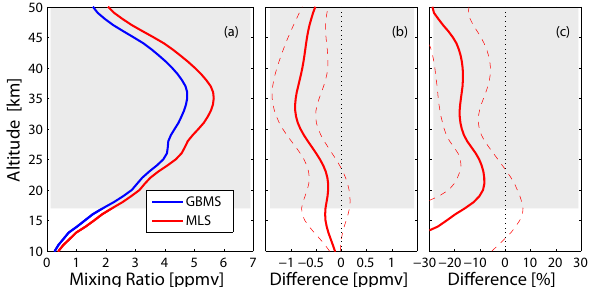
Fig. 3. Comparison of GBMS O 3 profiles with co-located Aura MLS observations obtained during the two winters 2011 and 2012 (54 coincidences). (a) GBMS (blue) and MLS convolved (red) mean profiles. (b) Mean absolute difference between GBMS and MLS convolved profiles. Dashed lines represent the stan- dard deviation of the mean difference. (c) As in (b) , but indicat- ing percent differences (calculated by dividing the mean differ- ence (GBMS − MLS) by the mean (GBMS+MLS)/2). The vertical range where the retrieval has a good sensitivity (>80%) is high- lighted with a grey